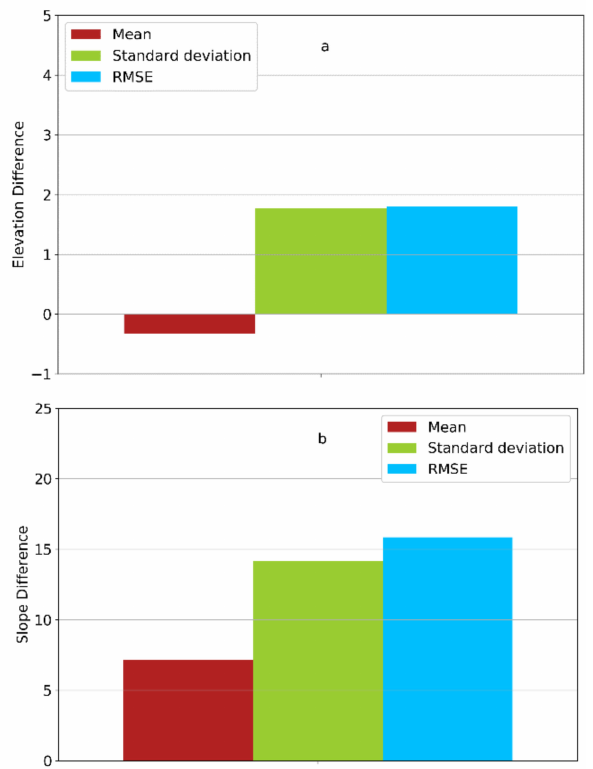
Figure 6. Elevation ( a ) and slope ( b ) errors.